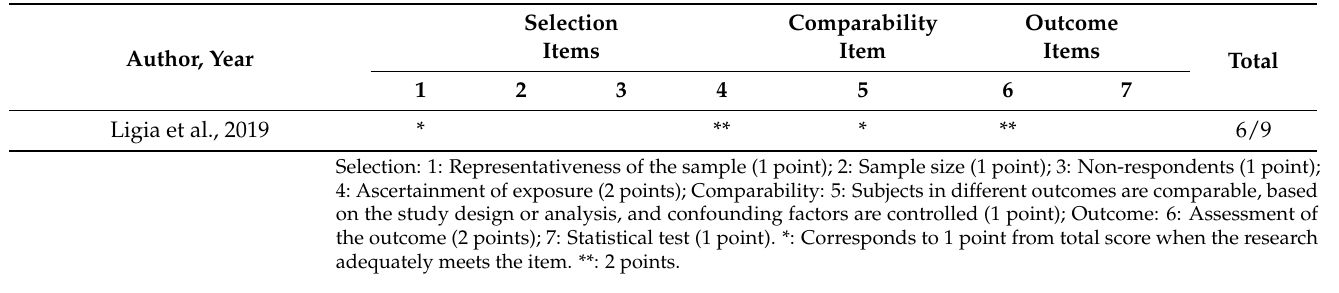
Table 2. Newcastle-Ottawa scale for cross-sectional study.